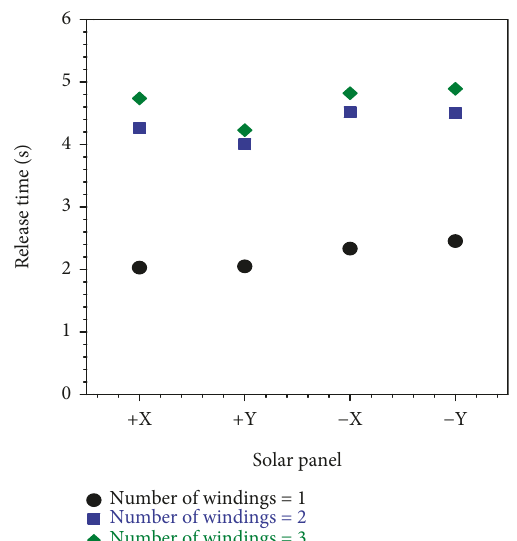
Figure 7: Release time of each solar panel according to the di ff erent numbers of nylon wire windings.